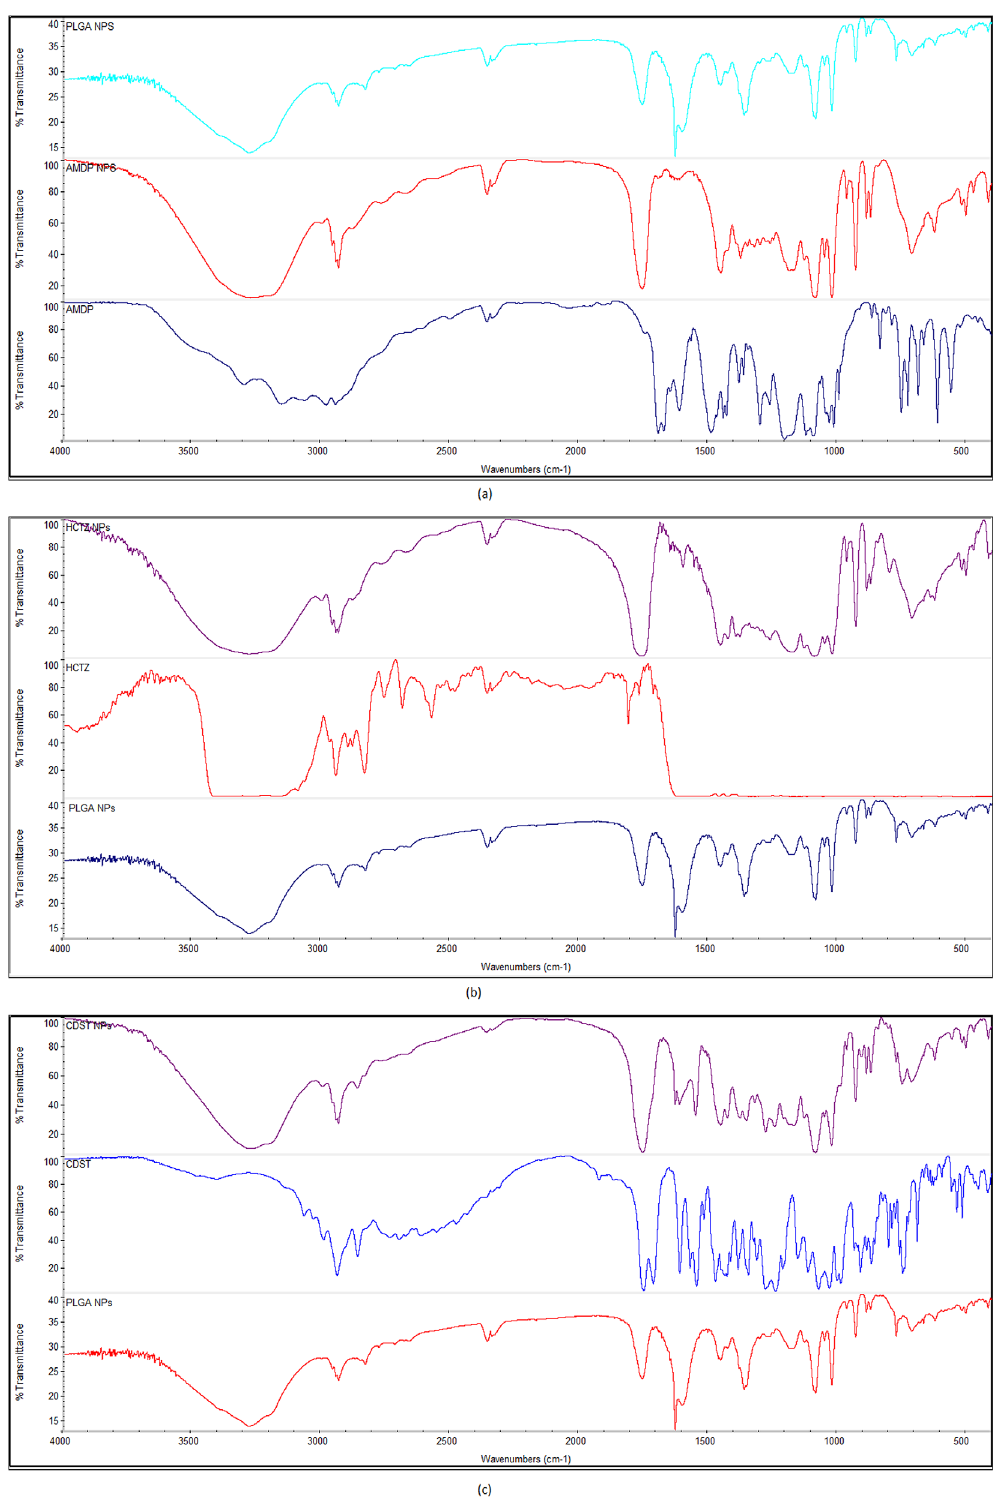
Fig 2. FT-IR spectra of (a) amlodipine (b) hydrochlorohiazide and (c) candesartan nanoparticles.